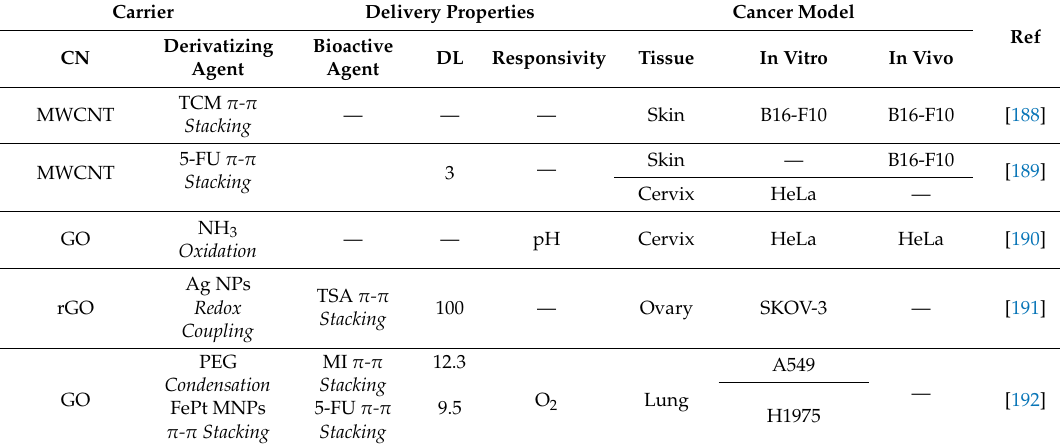
Table 5. MDR reversal by CN via cell